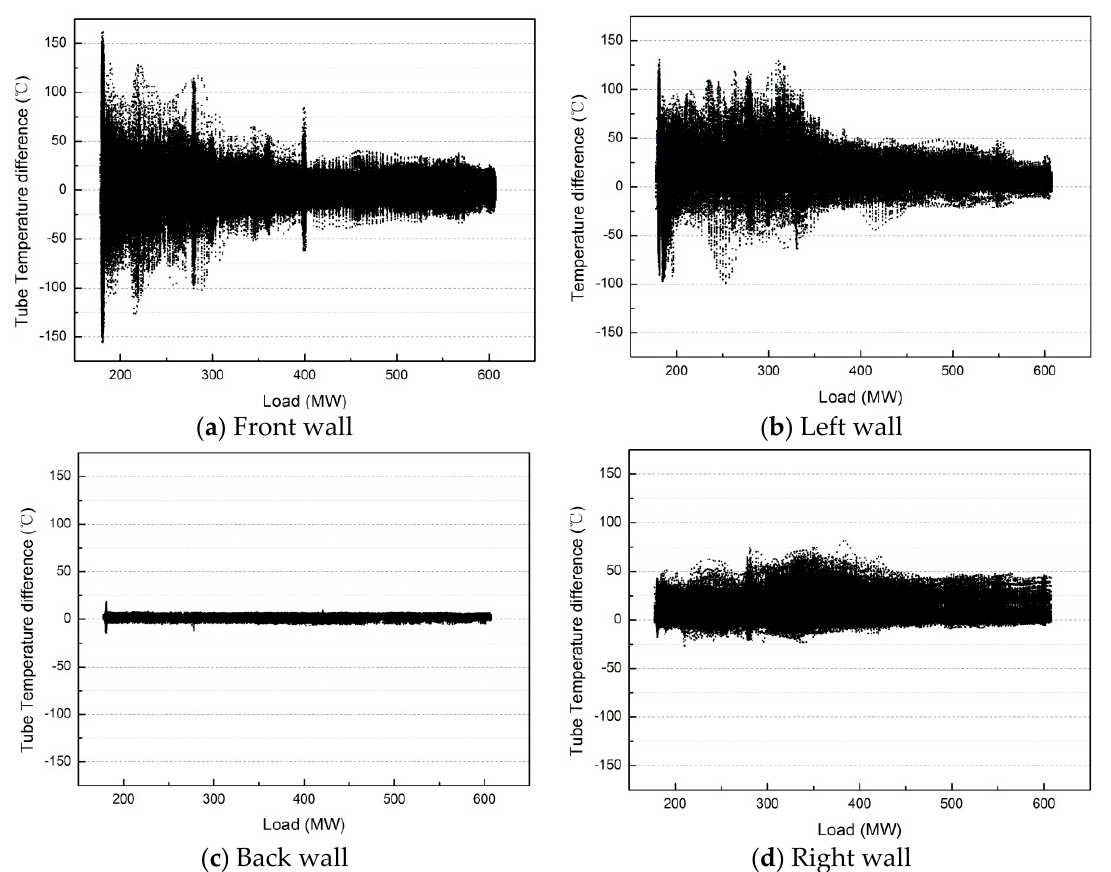
Figure 6. Tube temperature differences at the front, left, back, and right wall.